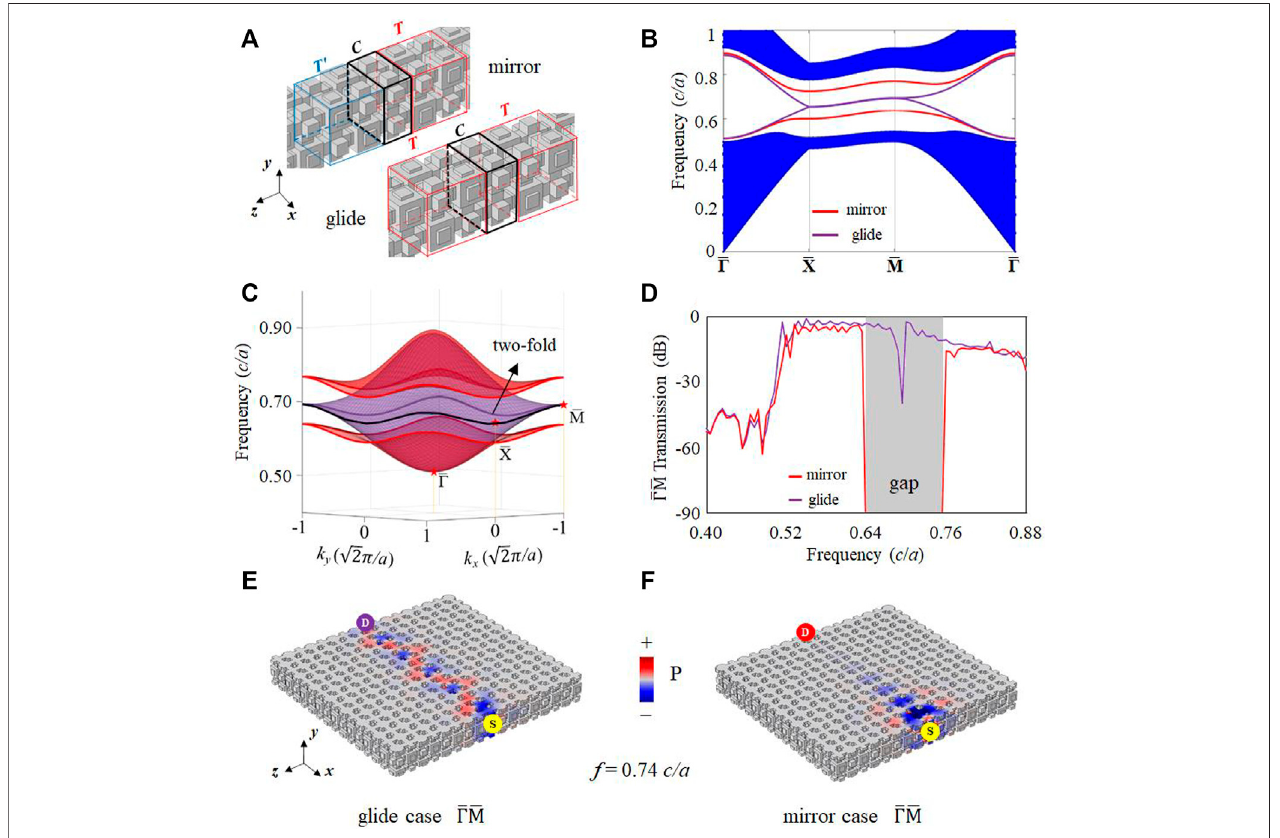
FIGURE6| Tunablesurfacestateswithmodi fi edinterfacelayer. (A) Supercellsofmirrorandglidecases.Theinterfacewithuniform o -typeacousticatoms(denoted as C). (B) Projected band structure. The red (purple) line represents the mirror (glide) case (C) A 3D view of surface states. (D) Γ (cid:2) M-direction transmission spectra. The shadow area represents the surface bandgap of the mirror case (E-F) Acoustic fi eld distributions at a frequency of 0.74 c/a .